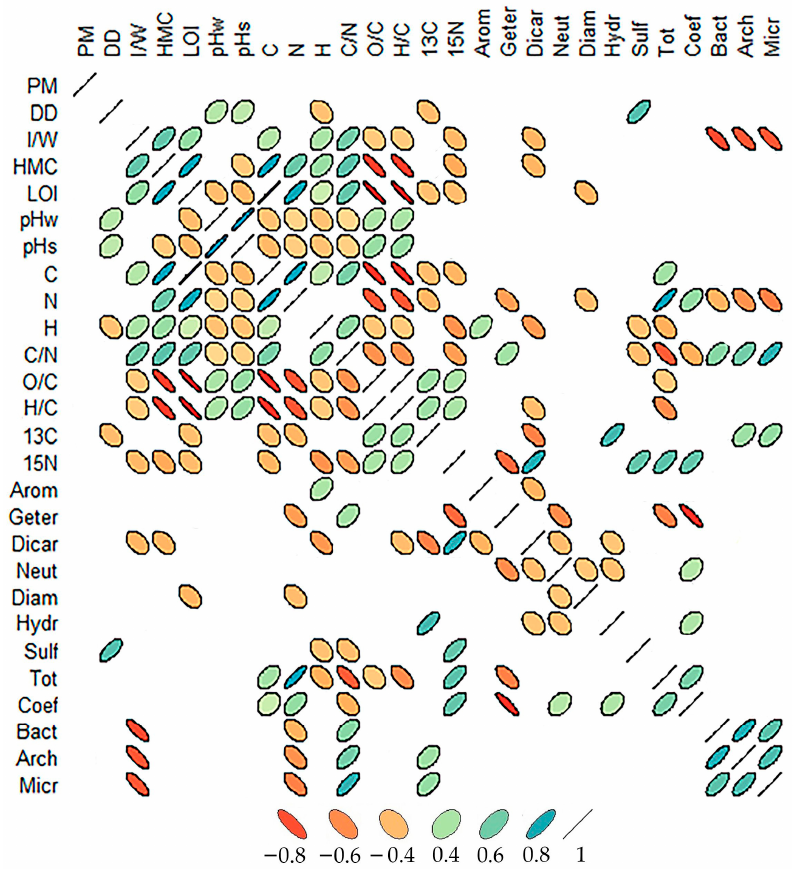
Figure 6. Pearson correlation coefficients between the amino acid composition, microbial community structure and the main physico-chemical peat properties. PM—plant macrofossils; DD— decomposition decree; %, I/W—Iciness/Wetness; HMC—Hygroscopic moisture coefficient;